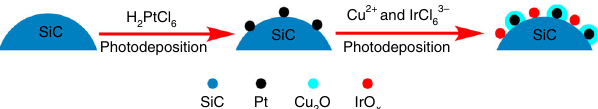
Fig. 1 Formation process of Cu 2 O – Pt/SiC/IrO x by photodeposition. Schematic representation of Cu 2 O – Pt/SiC/IrO x synthesis via controlled